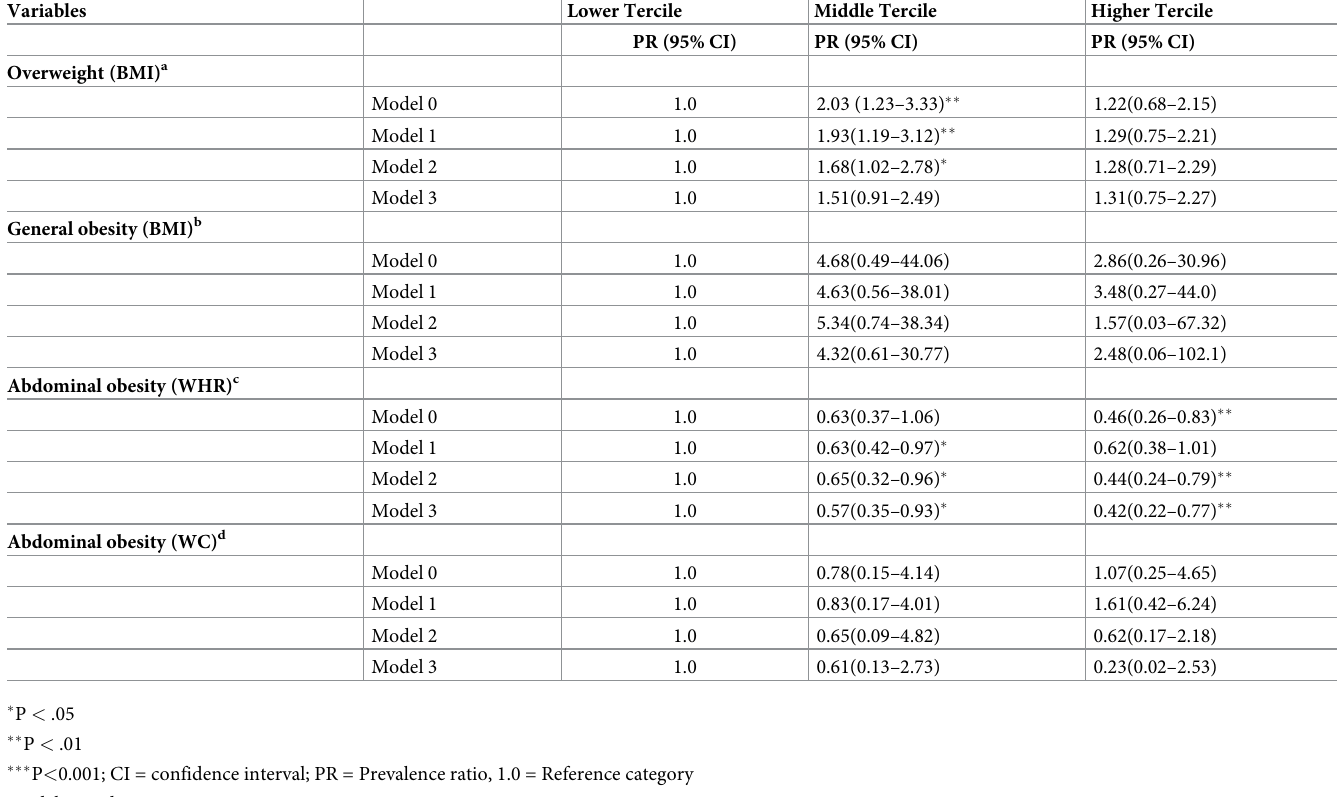
Table 3. Multivariate Poisson regressions (PR-Prevalence ratio and 95% confidence intervals) for dietary diversity (DDS Terciles) with overweight and obesity among male participants in Monduli district, Tanzania ( N =